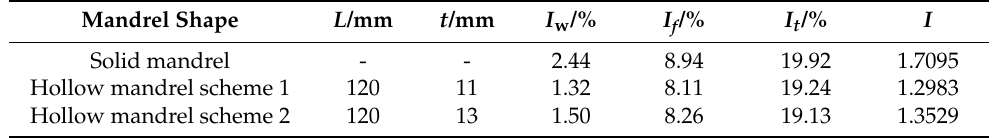
Table 8. Optimal parameters of the hollow section and corresponding forming results. Mandrel Shape L /mm t /mm I w /% Solid mandrel Hollow mandrel scheme 1 Hollow mandrel scheme